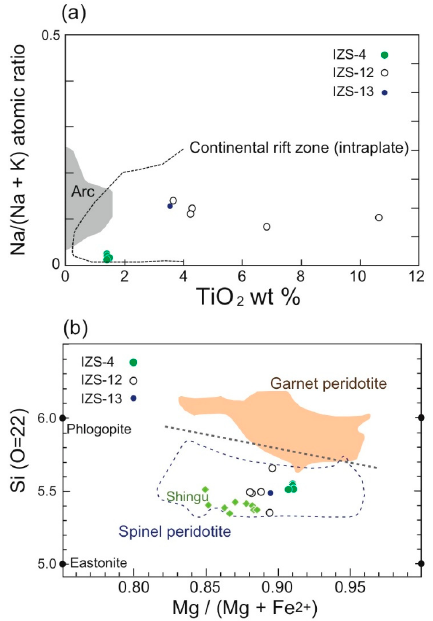
The Bankawa phlogopite is high in eastonite component (Si = ca. 5.5 on O = 22), being within the field of secondary phlogopites in spinel peridotite [73] (Figure 10b), consistent with the presence of spinel.